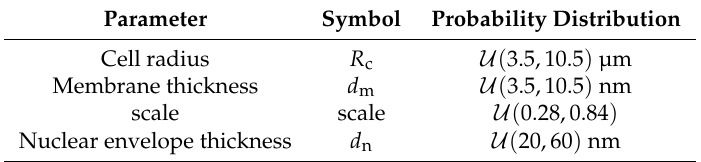
Table 4. Assumptions for the geometric properties of eukaryotic cells as reported in [65]. Note that instead of the explicit nucleus radius R n , a scale parameter was introduced such that R n = scale · R c . This ensures that the nucleus radius is always less than the cell radius. The uniform distribution is denoted by U